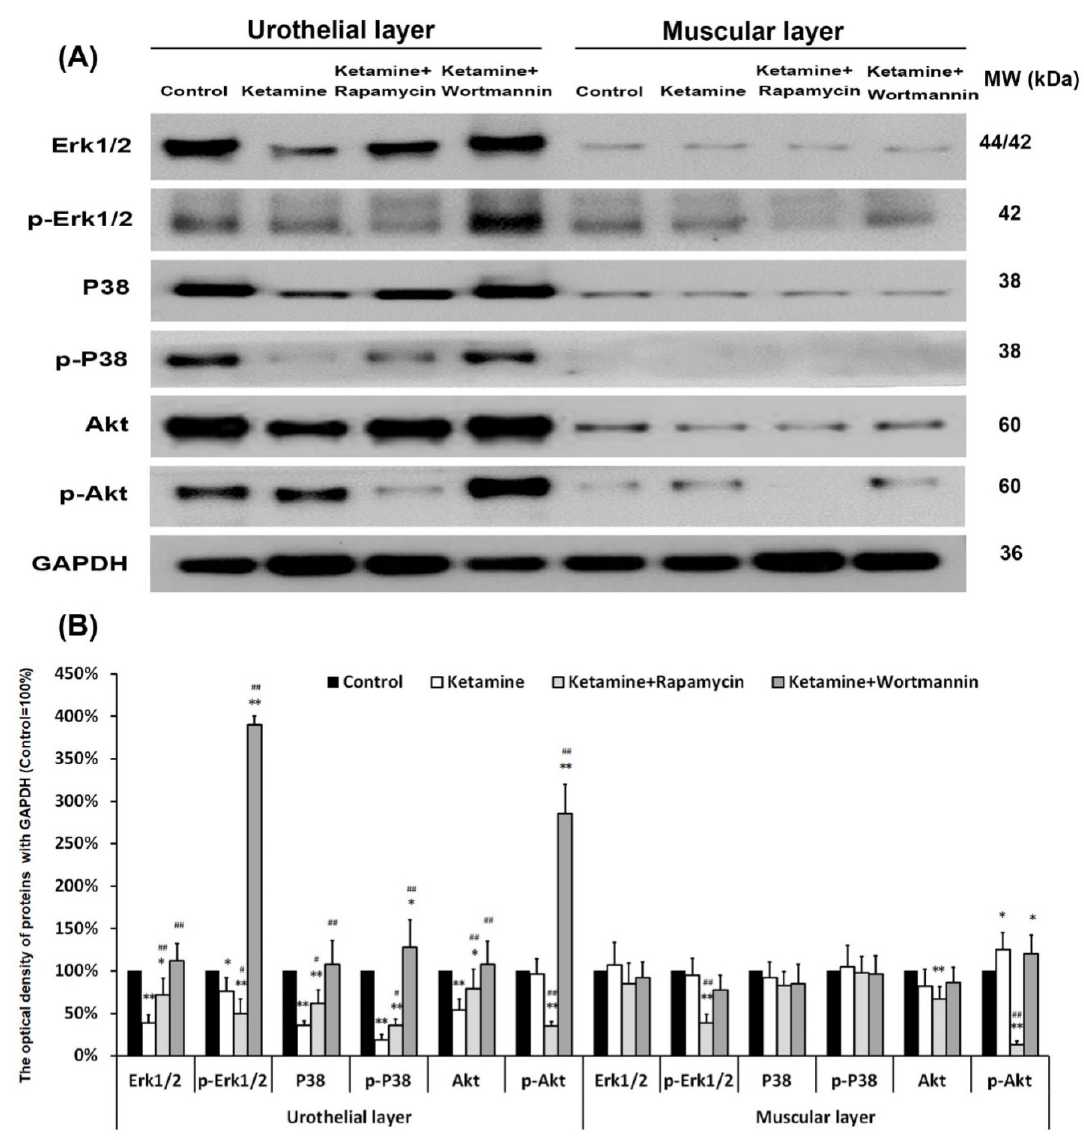
Figure 8. Western blots of signaling pathway kinase, including Erk1/2, p-Erk1/2, P38, p-P38, Akt, and p-Akt, were quantified against GAPDH ( A ). ( B ) Results were normalized to the control group (equal to 100%). The data revealed that treatment with ketamine significantly increased the Akt phosphorylation, but reduced the phosphorylation of Erk1/2 and p38 as compared to the control group. However, treatment with rapamycin increased the p38 phosphorylation, but suppressed the expression of p-Erk1/2 and p-Akt. Data were expressed as means ± SD for n = 6, * p < 0.05, ** p < 0.01 versus the control group; # p < 0.05, ## p < 0.01 versus the ketamine group.